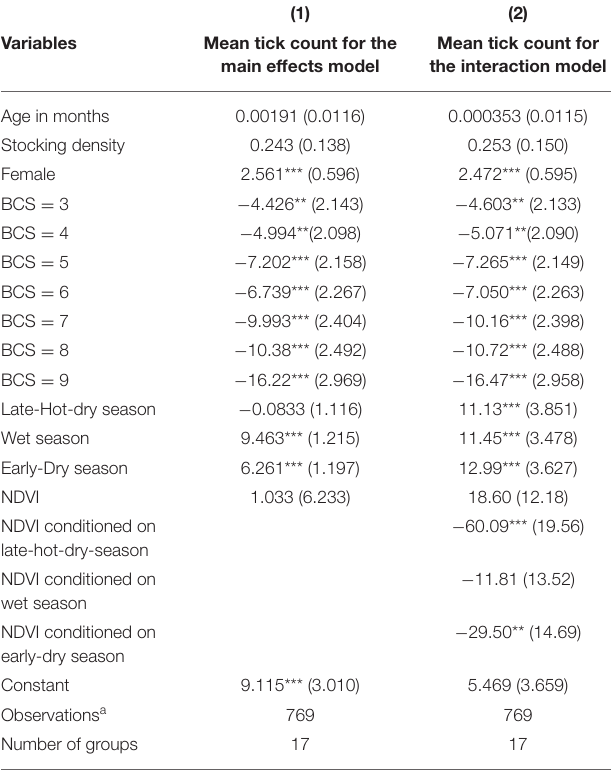
TABLE 1 | Random effects results for the dependency of tick count at the anno-vulva region of cattle brought for slaughter on select predictor variables, with age in months, stocking density at source extension area, sex with male as the baseline, body condition score (BCS) with BCS = 2 as baseline, Normalized Difference Vegetation Index (NDVI), and seasons of the year with cold-dry season as the